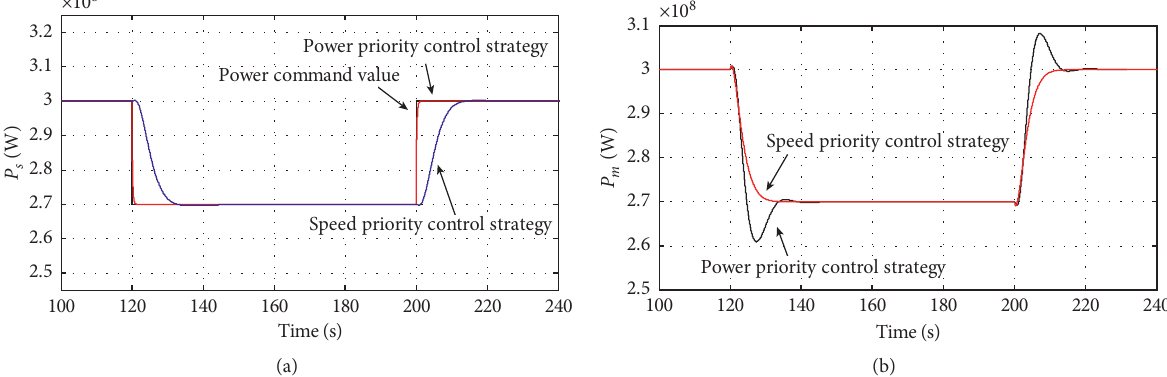
Figure 32: Active power comparison diagram when n power. (b) Comparison diagram of mechanical